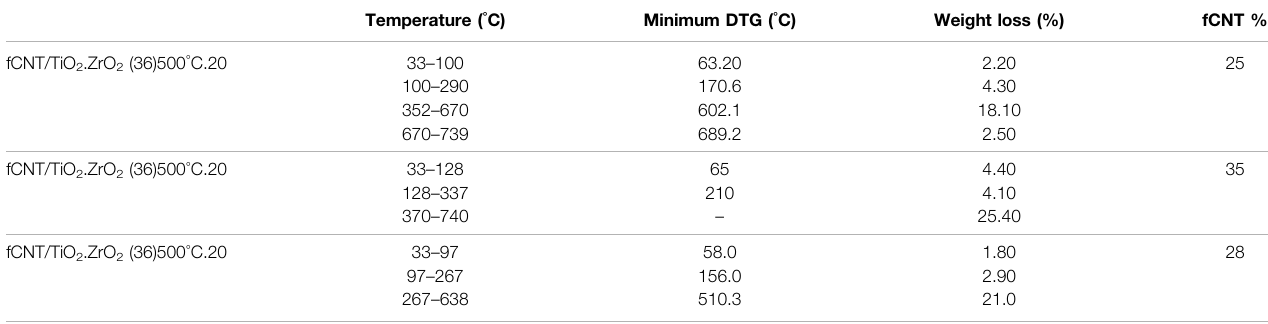
TABLE 2 | Thermogravimetric analysis.